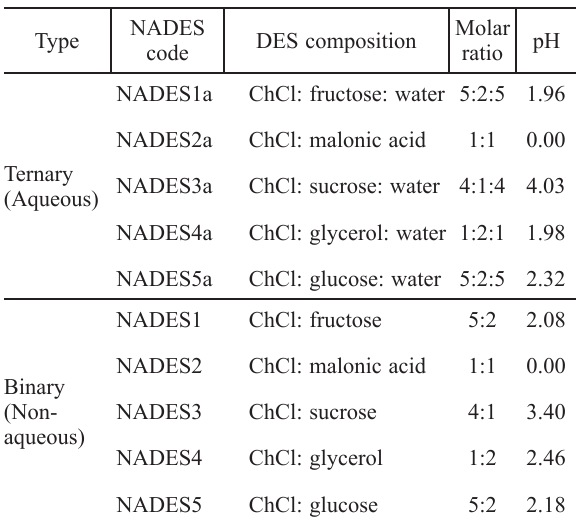
Table 2 – Compositions and molar ratios of the